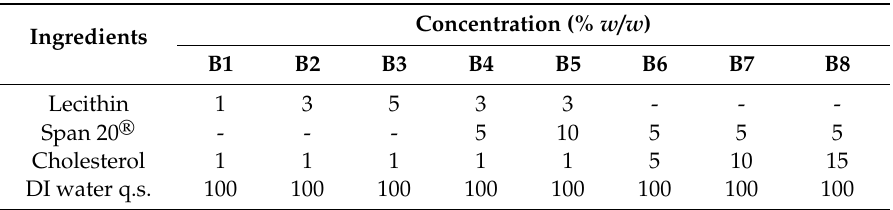
Table 2. Composition of liposome and niosome formulations.